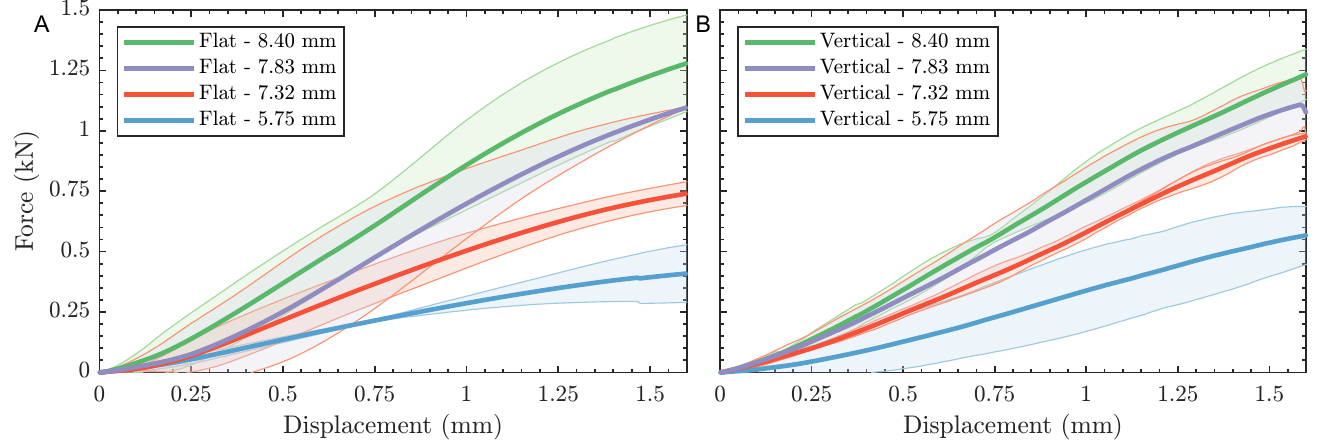
Figure 4. Force-displacement curves showing 3-point bending test results for ( A ) specimens printed on their flat side, and ( B ) specimens printed on their curved side. Each curve shows a solid line for the average of three measurements surrounded with a shaded area corresponding to ± 2 SDM.